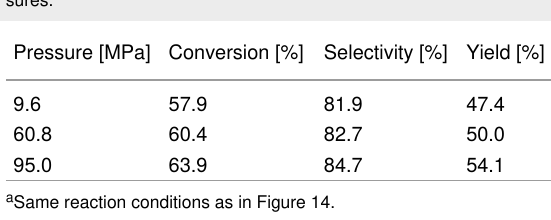
Table 6: Changes in conversion, selectivity, and yield at different pres-